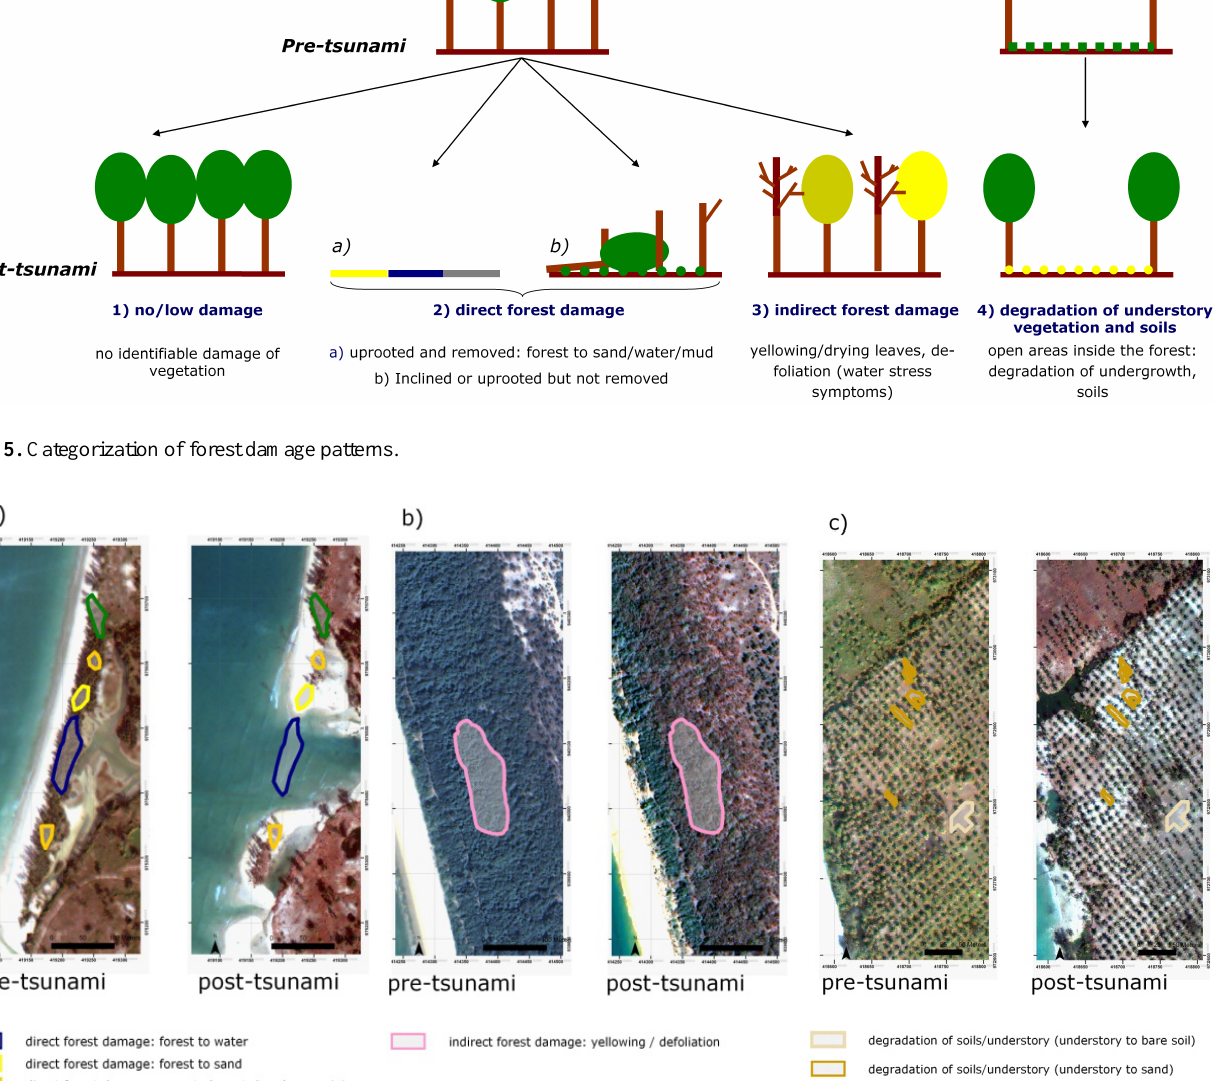
Fig. 6. Selection of training areas exemplified for seven different change classes. (a) casuarina beach forest near Ban Bang Sak, (b) mixed beach forest in Thai Mueang, and (c) coconut plantation near Ban Bang Sak.